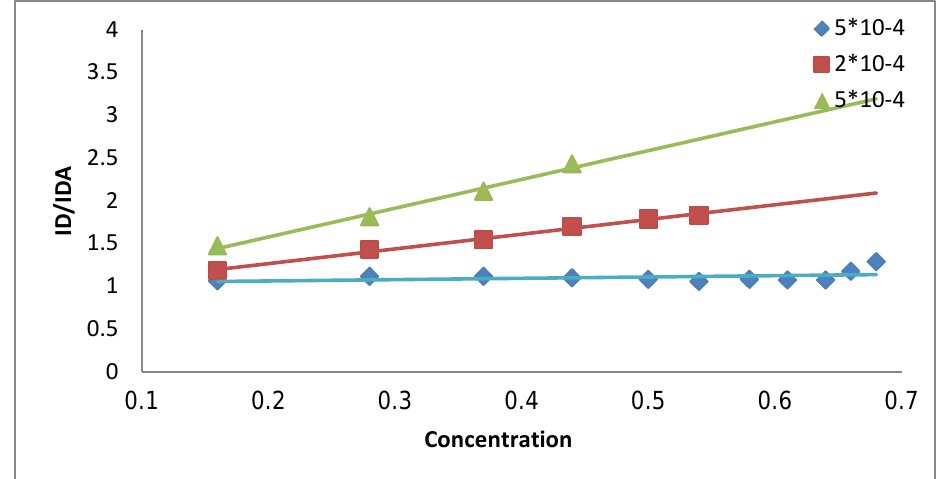
Fig. 8: Stern-Volmer plot for Coumarin 334 doped with Rhodamin 590 dye mixture in ethanol as a function of acceptor concentration.